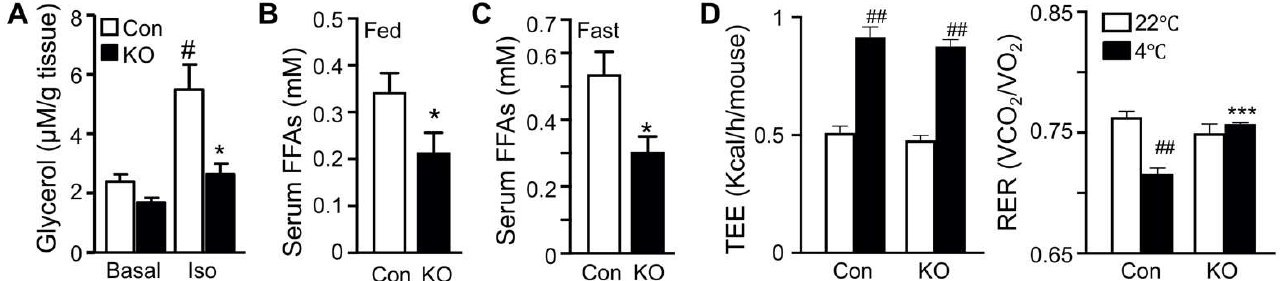
Figure 1. Deletion of adipose CGI-58 reduces serum FFA concentrations and increases whole-body glucose utilization. ( A ) Ex vivo lipolysis of iWAT explants from 14-week-old chow-fed mice ( n = 5/group). Glycerol concentrations in the medium of cultured iWAT explants were measured after a 2 h incubation at 37 °C in the absence (Basal) or presence of isoproterenol (Iso). ( B , C ) Serum concentrations of FFAs in the 15-week-old HFD-fed mice in the fed state ( B ) and in the 17-week-old HFD-fed mice after overnight fasting ( C ) ( n = 5–6/group). ( D ) The respiratory exchange ratio (RER) and the total energy expenditure (TEE) in 23-week-old FAT-KO and control mice fed the HFD ad libitum at room temperature and during cold exposure. The RER and TEE shown represent the data continuously collected for 3 h immediately before and 1 h after the switch of the housing temperature from 22 °C to 4 °C ( n = 4–6/group). ( E ) Insulin and glucose tolerance tests in mice fed a chow diet ( n = 5–6/group) or HFD starting at six weeks of age ( n = 7–8/group) at room temperature. ( F ) Serum levels of insulin, glucose, and fasting homeostatic model assessment of insulin resistance (HOMA-IR) indexes in 17-week-old HFD- fed mice ( n = 5–6/group). ( G ) Blood glucose levels of 11-week-old HFD-fed mice during acute cold exposure ( n = 4– 5/group). The mice were fasted for ~6 h during the daytime cycle and then exposed to 4 °C for 1 h prior to intraperitoneal injection of a bolus of glucose at 1.5 g/kg BW while remaining at 4 °C for the time indicated. * p < 0.05, ** p < 0.01, and *** p < 0.001 vs. genotype; # p < 0.05 vs. treatment; ## p < 0.001 vs. housing temperature by two-tailed unpaired Student’s t - test. 2.2. CGI-58 Deletion in the Adipose Tissue Increases Glucose Uptake in the Heart Increased glucose disposal suggests enhanced tissue glucose uptake. Adipose and muscle tissues are major sites responsible for glucose disposal in peripheral organs. We, therefore, measured glucose uptake in these tissues by using the radioactive 2-deoxyglu- cose as a tracer. Under the insulin-stimulated condition, the hearts of FAT-KO mice rela- tive to the control mice showed a >2-fold increase in glucose uptake (Figure 2A). Remark- ably, cardiac glucose uptake increased >10-fold during acute cold exposure without insu- lin administration (Figure 2B). Relative to the heart, other tissues including interscapular brown adipose tissue, inguinal WAT, epididymal WAT, gastrocnemius muscle,